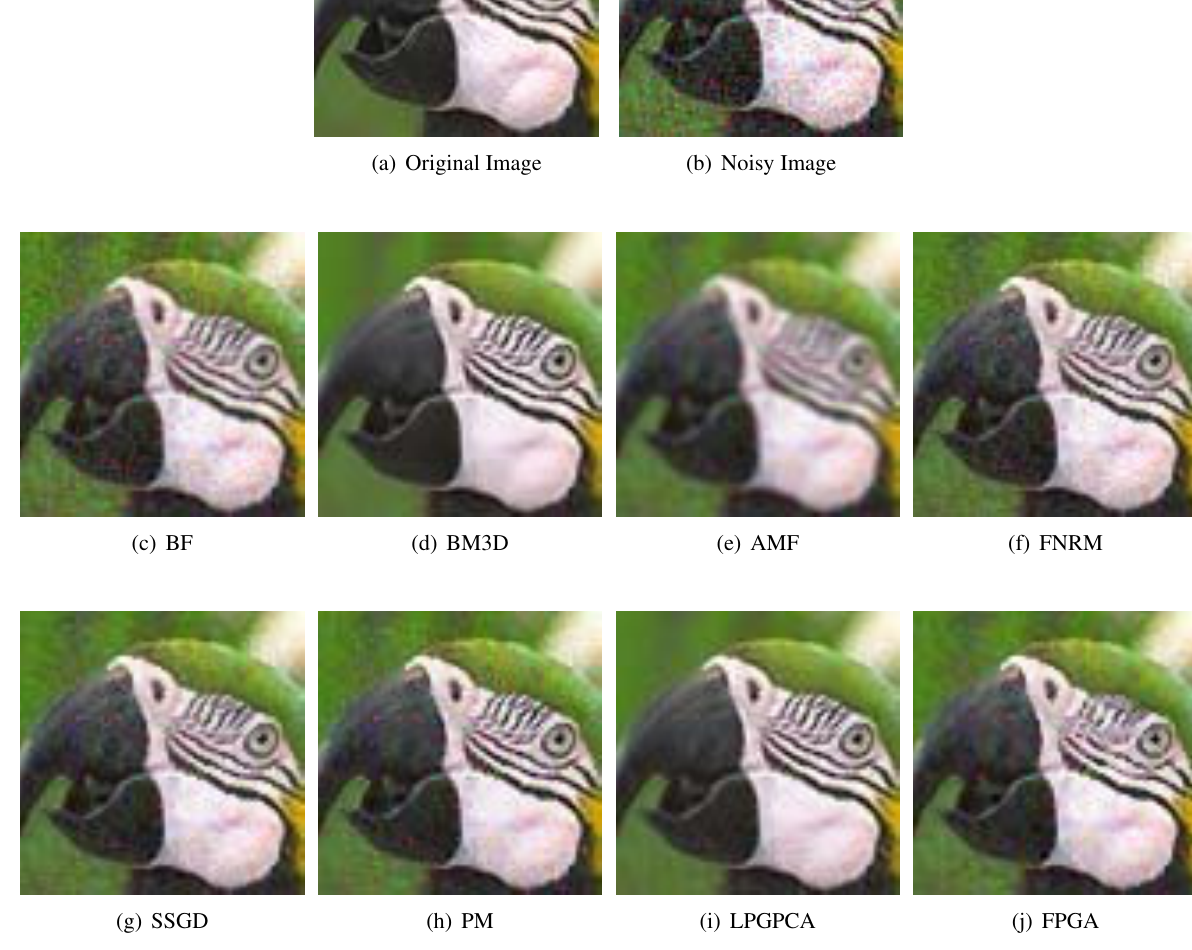
Fig. 2 Results under different smoothing methods applied to Parrots image corrupted by a Gaussian noise with standard deviation σ = 20.